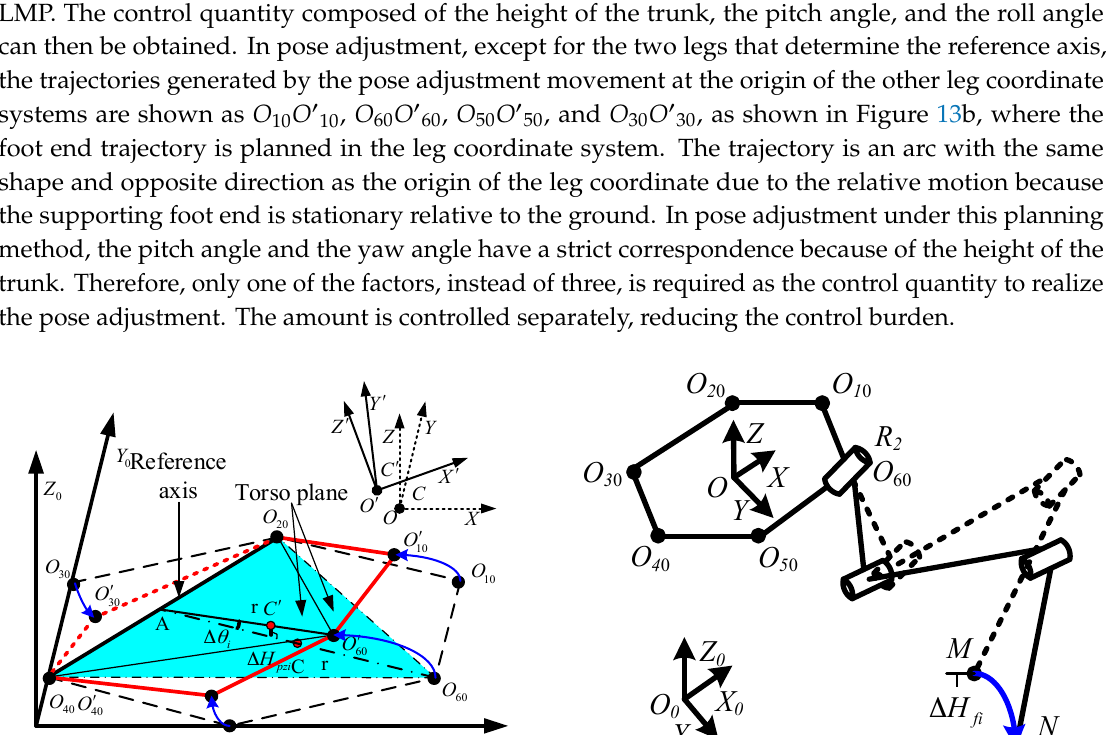
Figure 12. Analysis of main support polygon: ( a ) Configuration polygon with three stance legs, identification of light rough terrain, ( b ) configuration polygon with four stance legs, and ( c ) configuration polygon with five stance legs.